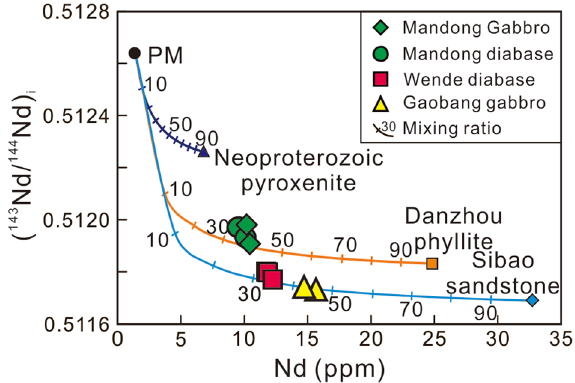
Figure 9. Whole rock ( 143 Nd/ 144 Nd) i versus Nd (ppm) diagram showing the modeling results for crustal contamination for the Early Cretaceous mafic